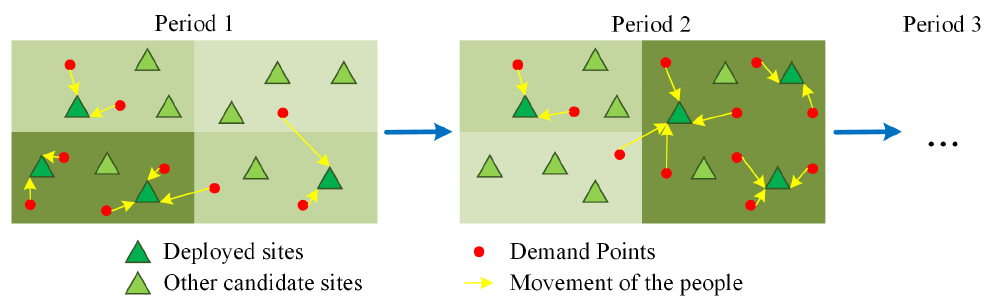
Figure 2. Illustration of the planning